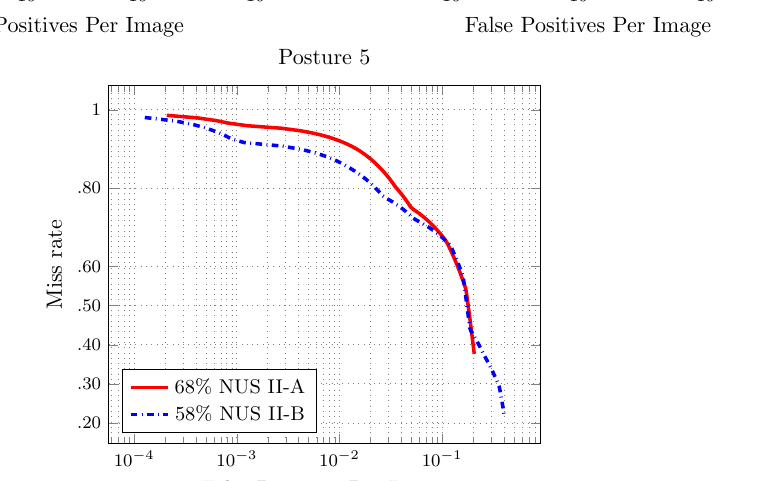
Figure 7. Results of the full image evaluation for Hand Postures 1–5 in Figure 2. The score is the log average of the miss